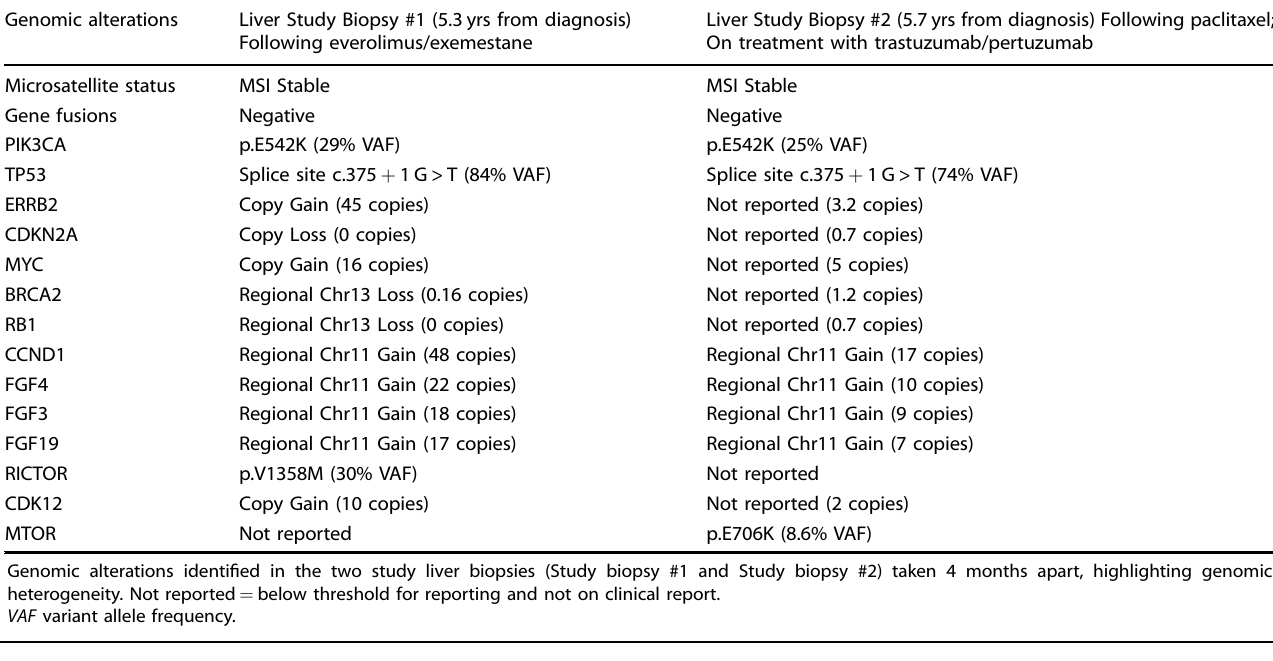
Table 1. Comparison of alterations in Study biopsies identi fi ed by NGS panel